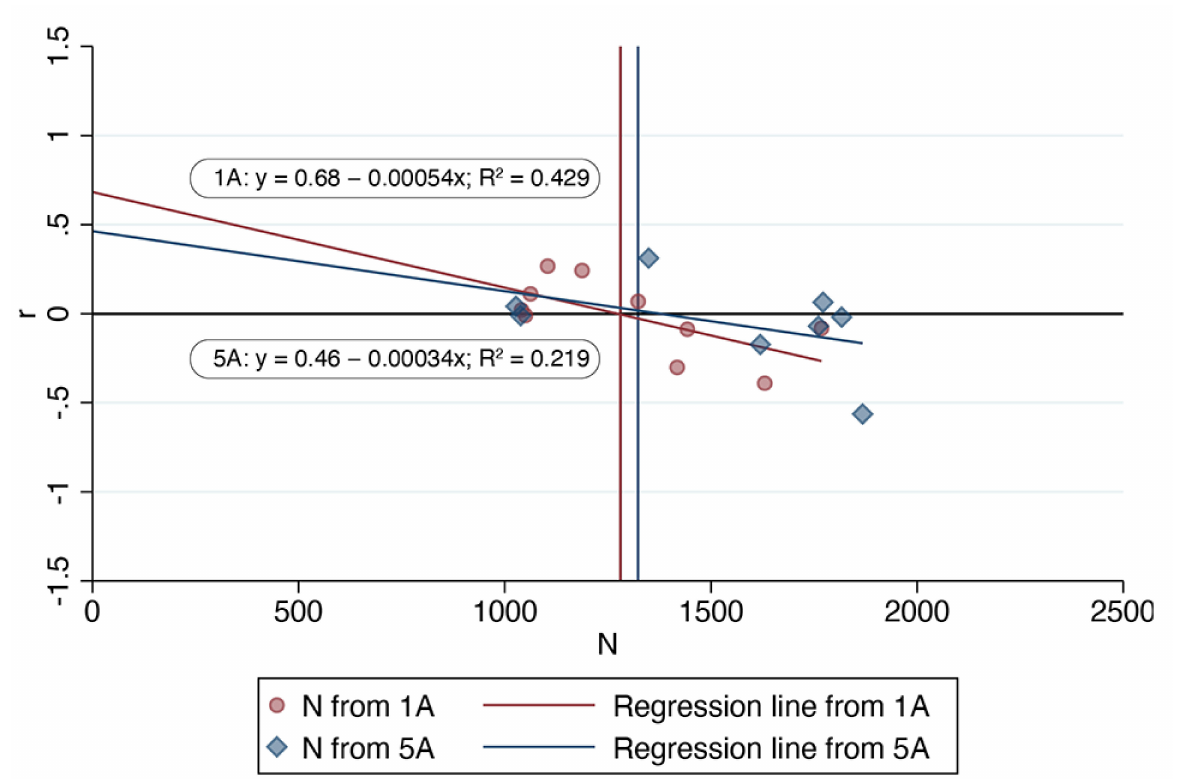
Figure 1. Calculated per capita growth rate vs. annual sterilization surgeries, San Diego County 1993–2002, estimated from Foley et al. [22] Figures 1A and